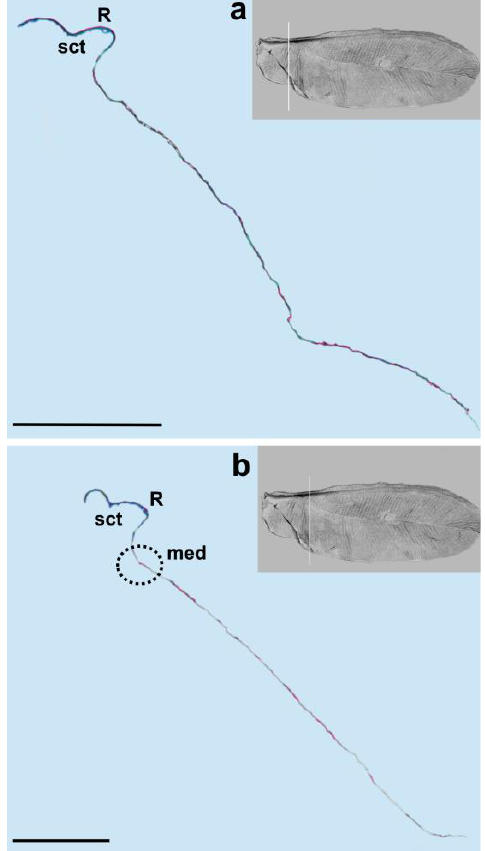
Figure 4. (a) Cross-section of the wing of M. pini . Scale bar 100 μm; (b) median fold in black dotted Figure 4. Cross-section of the wing of M. pini . Scale bar 100 µ m; ( a , b ) median fold in black dotted circle